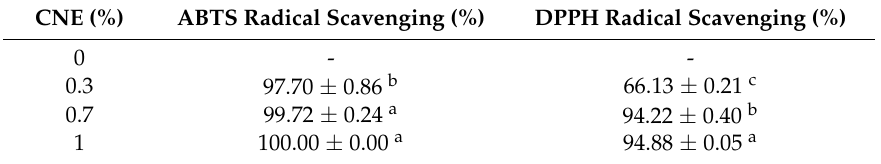
Table 3. Antioxidant activities of ABS films containing various amounts of cocoa nibs extract. CNE (%) ABTS Radical Scavenging (%) DPPH Radical Scavenging